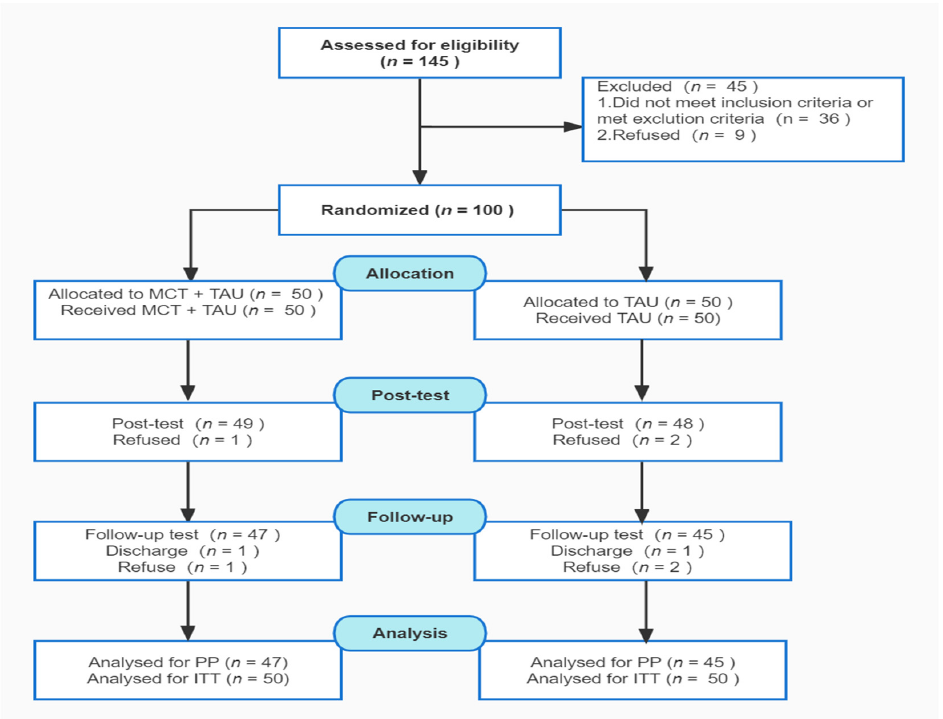
Figure 1. CONSORT flow chart.